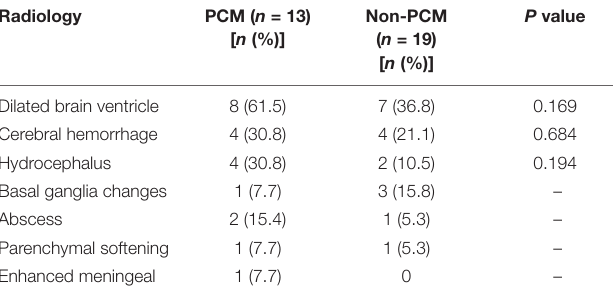
TABLE 2 | Comparisons of the radiology of patients with and without